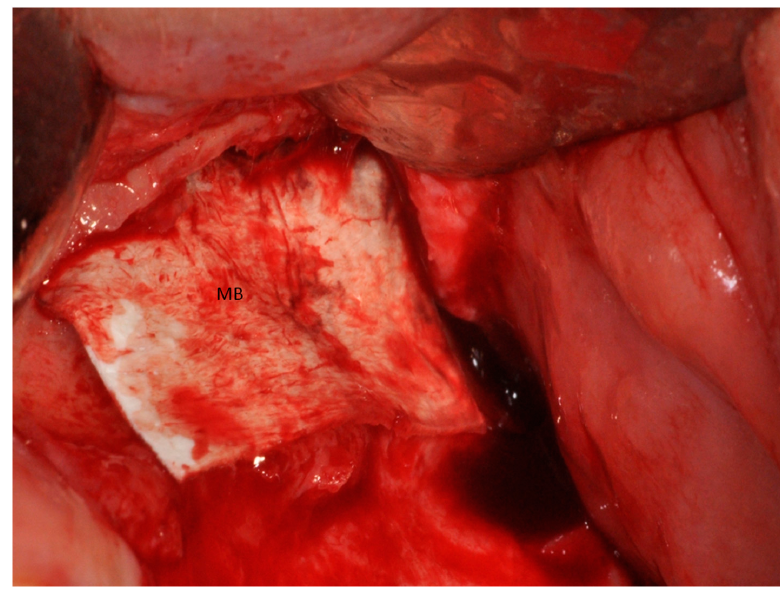
Figure 11. Half of the heterologous membranes external of the sinus was folded to cover the window (MB). In Group II, the sinuses were treated with heterologous cortical lamina only (Lamina, OsteoBiol, Turin, Italy), and the coagulum was observed underneath the elevated sinus mucosa. The heterologous membrane was folded to cover the antrostomy. The operative time to complete the regenerative procedure (expressed in minutes) starting from antrostomy to the end of closing the lateral window was calculated.